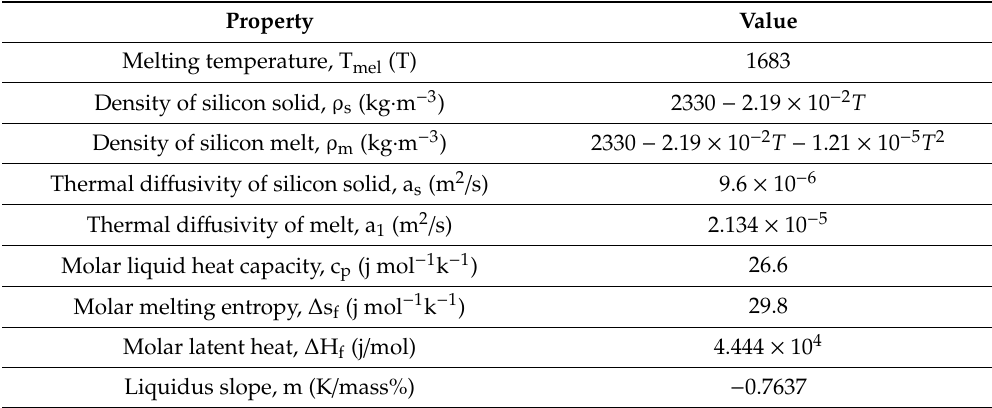
Table 1. Physical properties and calculation parameters used in the present model.